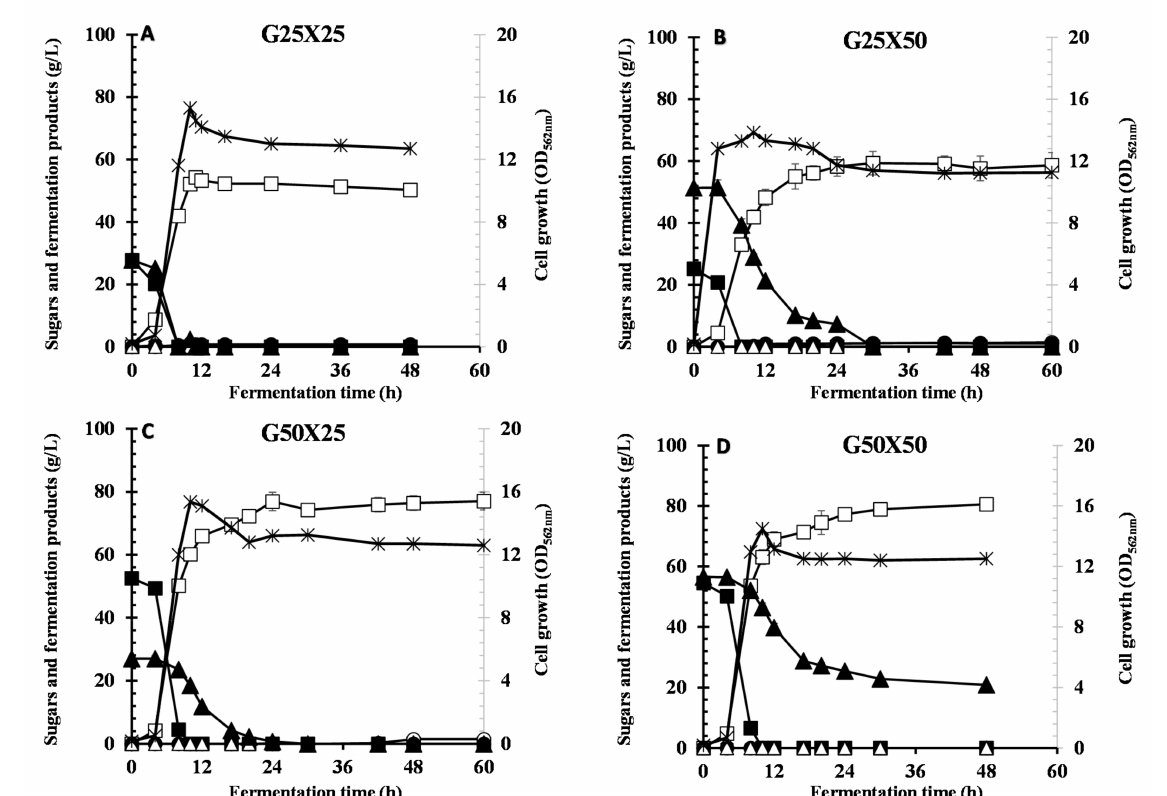
Figure 1. Effect of different glucose/xylose concentrations on the growth and lactic acid production by B. coagulans Azu-10. ( A ) fermentation of 25 g/L glucose and 25 g/L xylose [G25X25]; ( B ) fermentation of 25 g/L glucose and 50 g/L xylose [G25X50]; ( C ) fermentation of 50 g/L glucose and 25 g/L xylose [G50X25]; ( D ) fermentation of 50 g/L glucose and 50 g/L xylose [G50X50]. Symbols: (cid:4) , glucose (g/L); (cid:78) , xylose (g/L); (cid:3) , lactic acid (g/L); , acetic acid (g/L); • , formic acid (g/L); ∆ , ethanol (g/L); *, growth (OD (cid:35) 562 nm